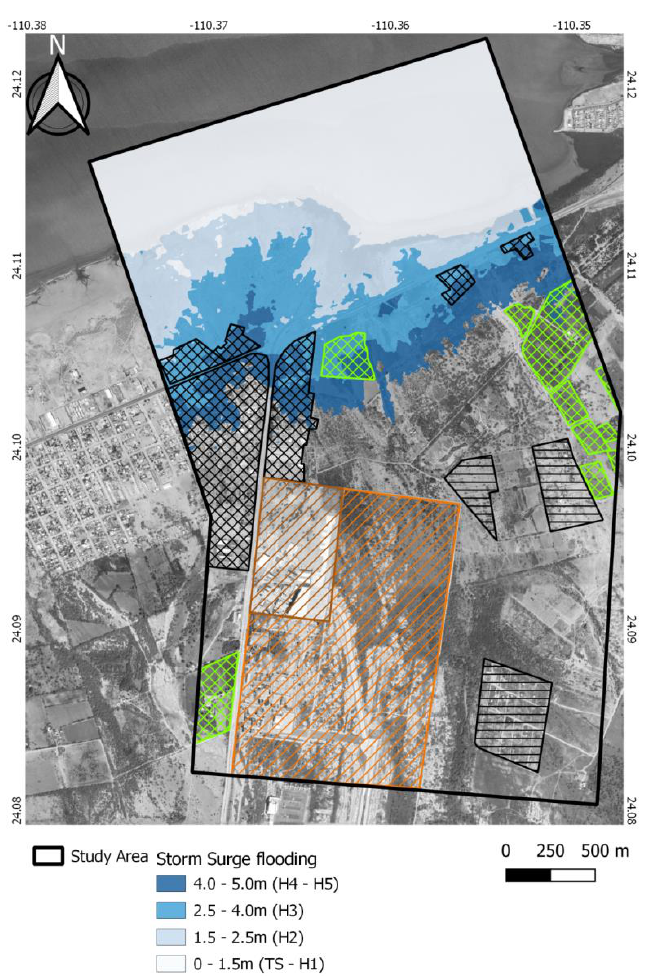
Figure 7. Extent of flooding in the coast as a result of different scenarios of storm surge. Dark blue represents the scenario with less probability of occurrence, light blue is the scenario with the higher probability of